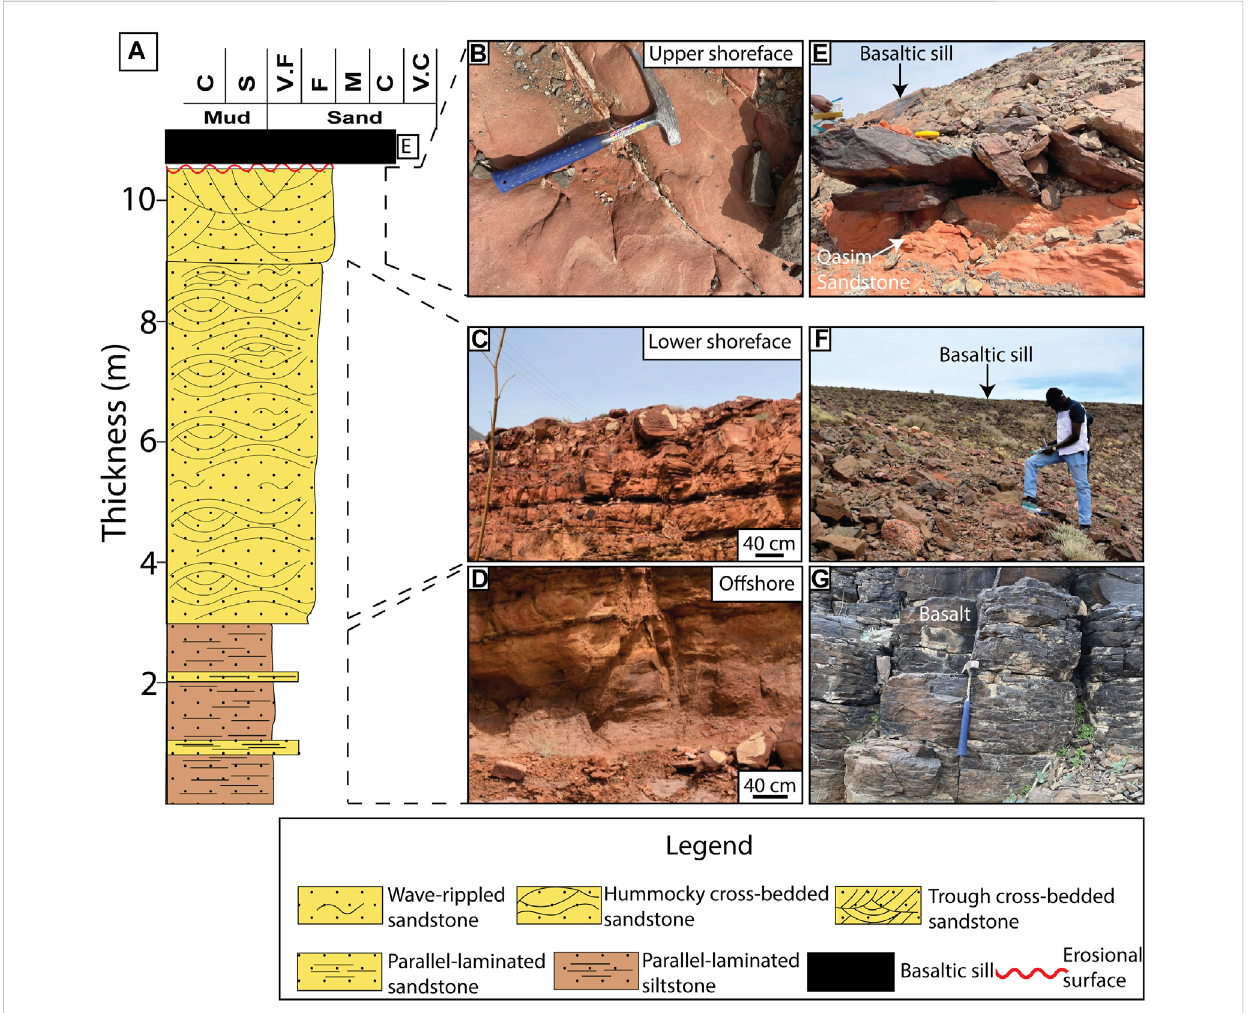
FIGURE 5 Sedimentaryfaciesand interpreted depositionalenvironments of thestudied Qasim sandstones. (A) Stratigraphic log for thestudied sandstones. (B) Upper shoreface facies (trough cross bedded sandstone). (C) Lower shoreface facies. (D) Offshore facies. (E) Basaltic sill overlying the Qasim sandstone. (F) Laterally extensive basaltic sill. (G) Close-up view of the relatively thick basaltic sill (Location 1; see Figure